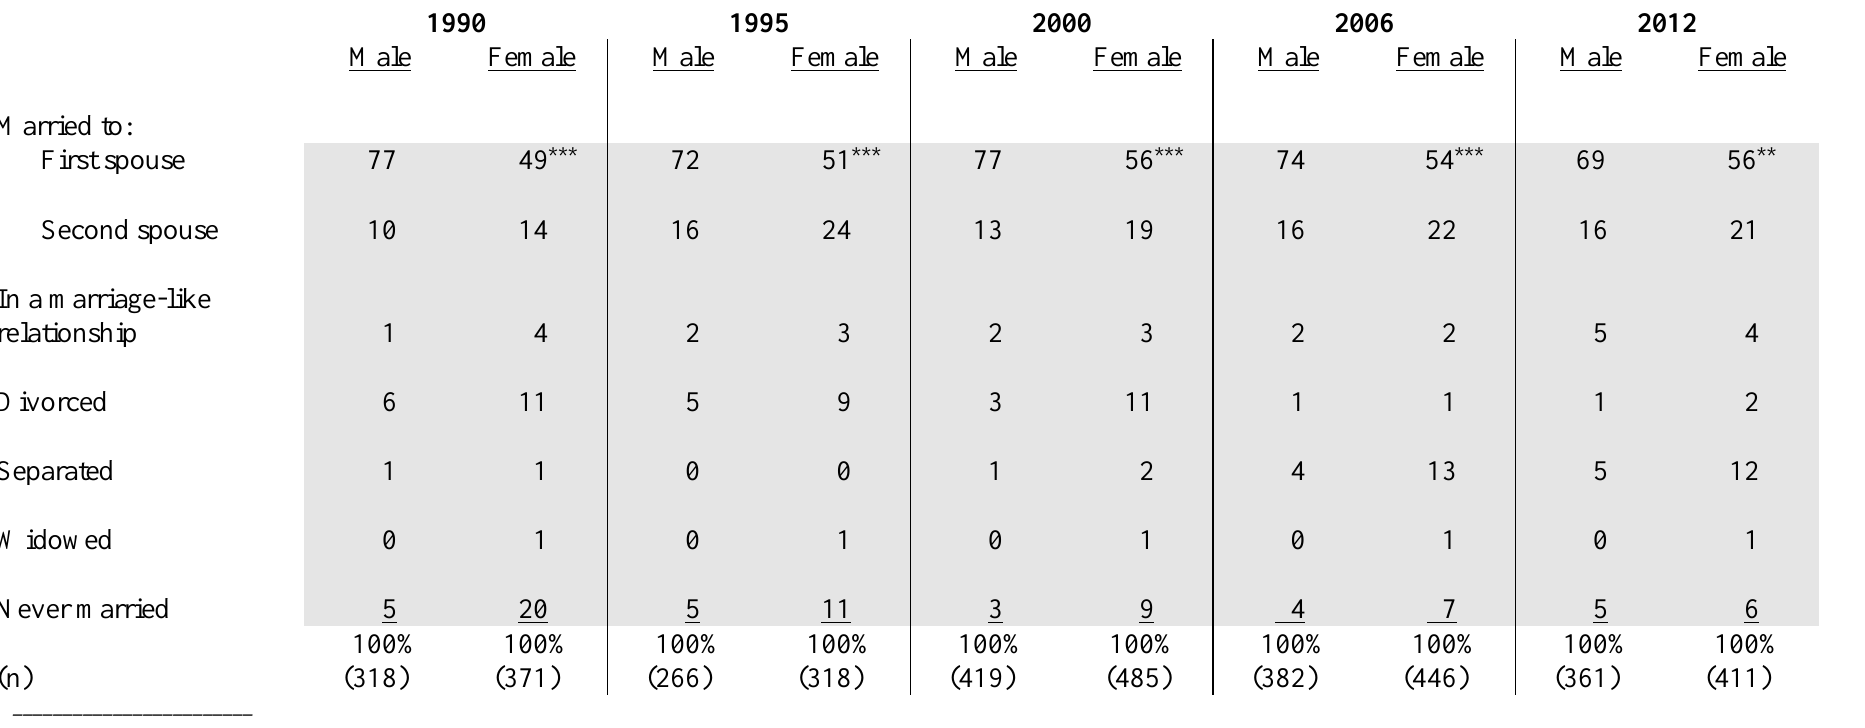
Table 17. Current Marital Status